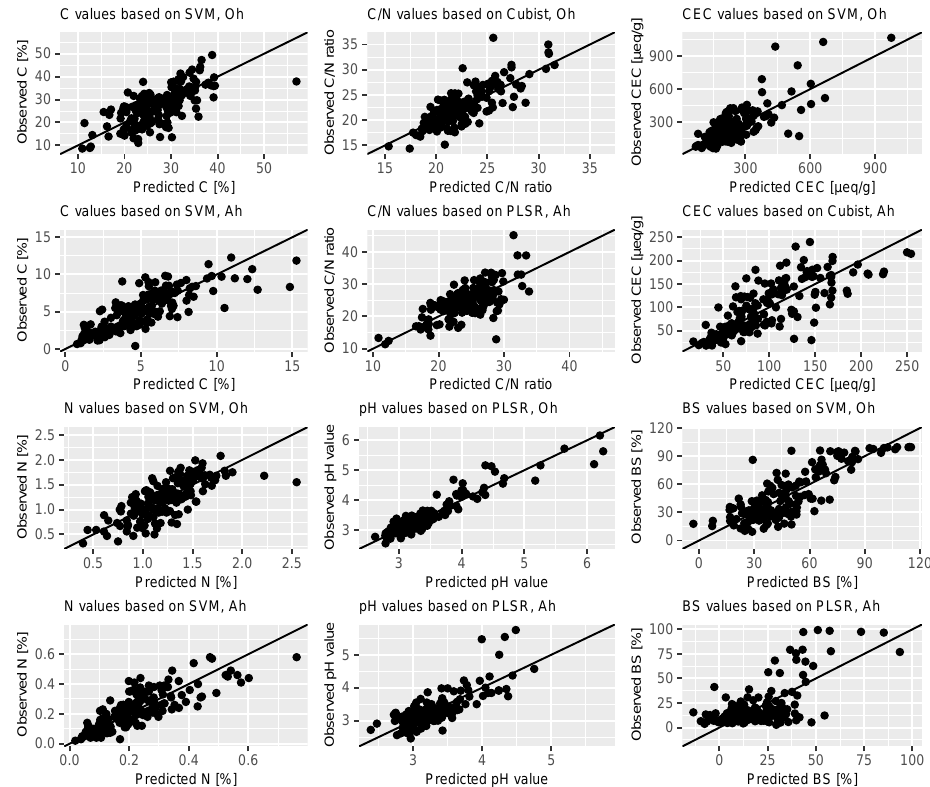
Figure 6. Predicted vs. observed plots for the investigated properties separated by horizon, results of the most accurate algorithm per